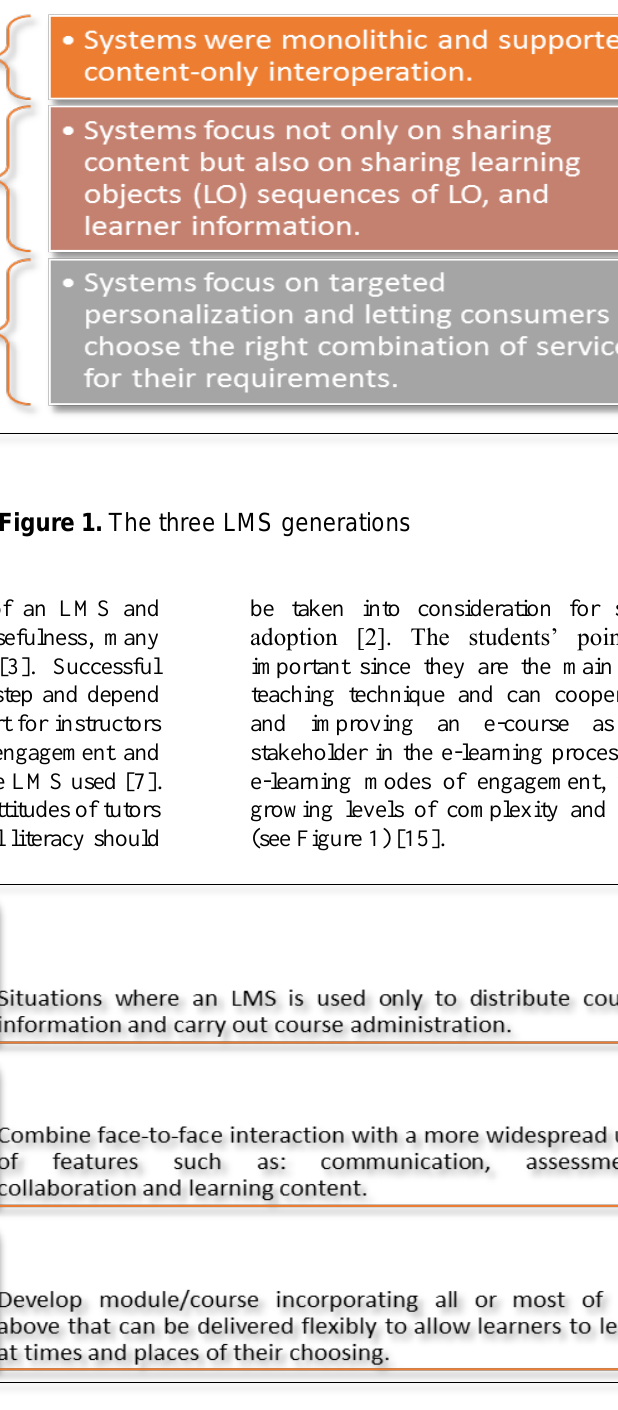
Figure 2. Three e-learning modes of engagement in LMS